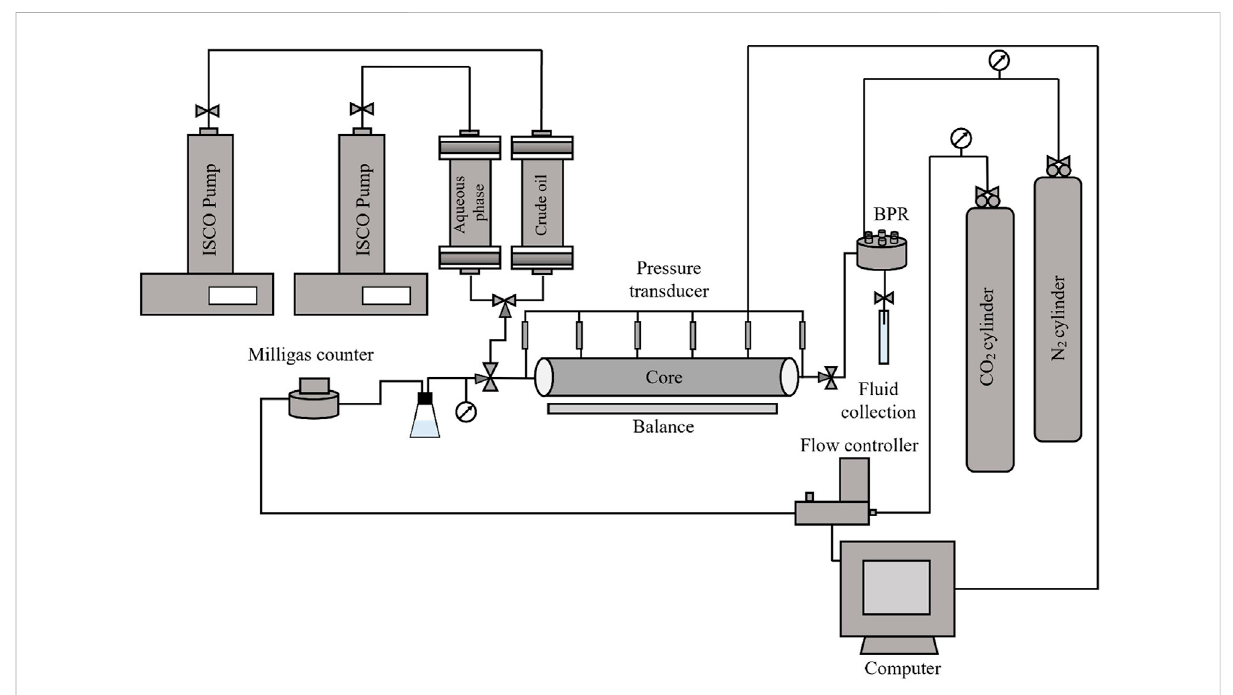
FIGURE 1 Schematic of foam fl ow experimental